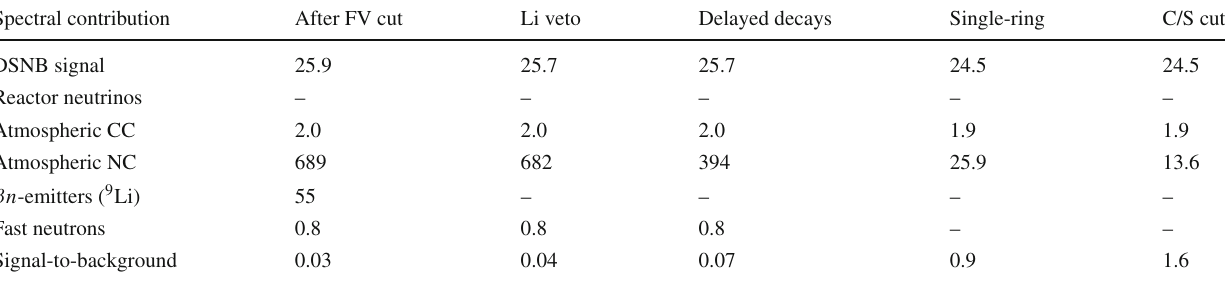
Table6 RatesofDSNBsignalandbackgrounds withintheobservation window (8–30MeV) for a live exposure of 100kt · years. While the first column represents the rates before cuts, the following columns